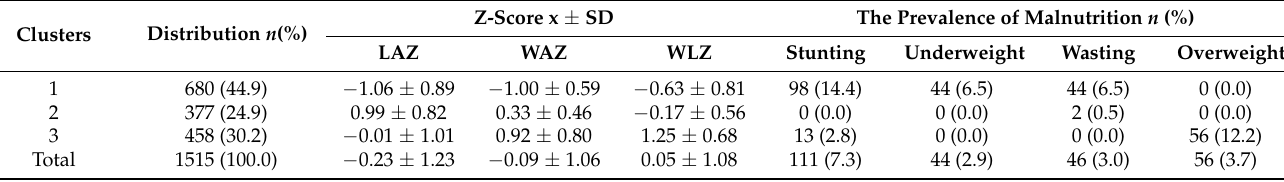
Table 2. Clusters grouped by